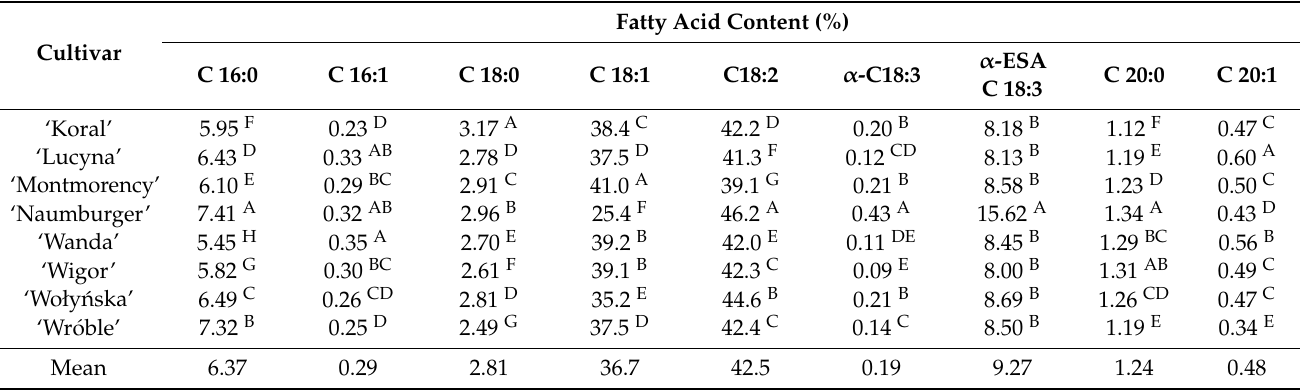
Table 3. Fatty acid composition in oils from different sour cherry